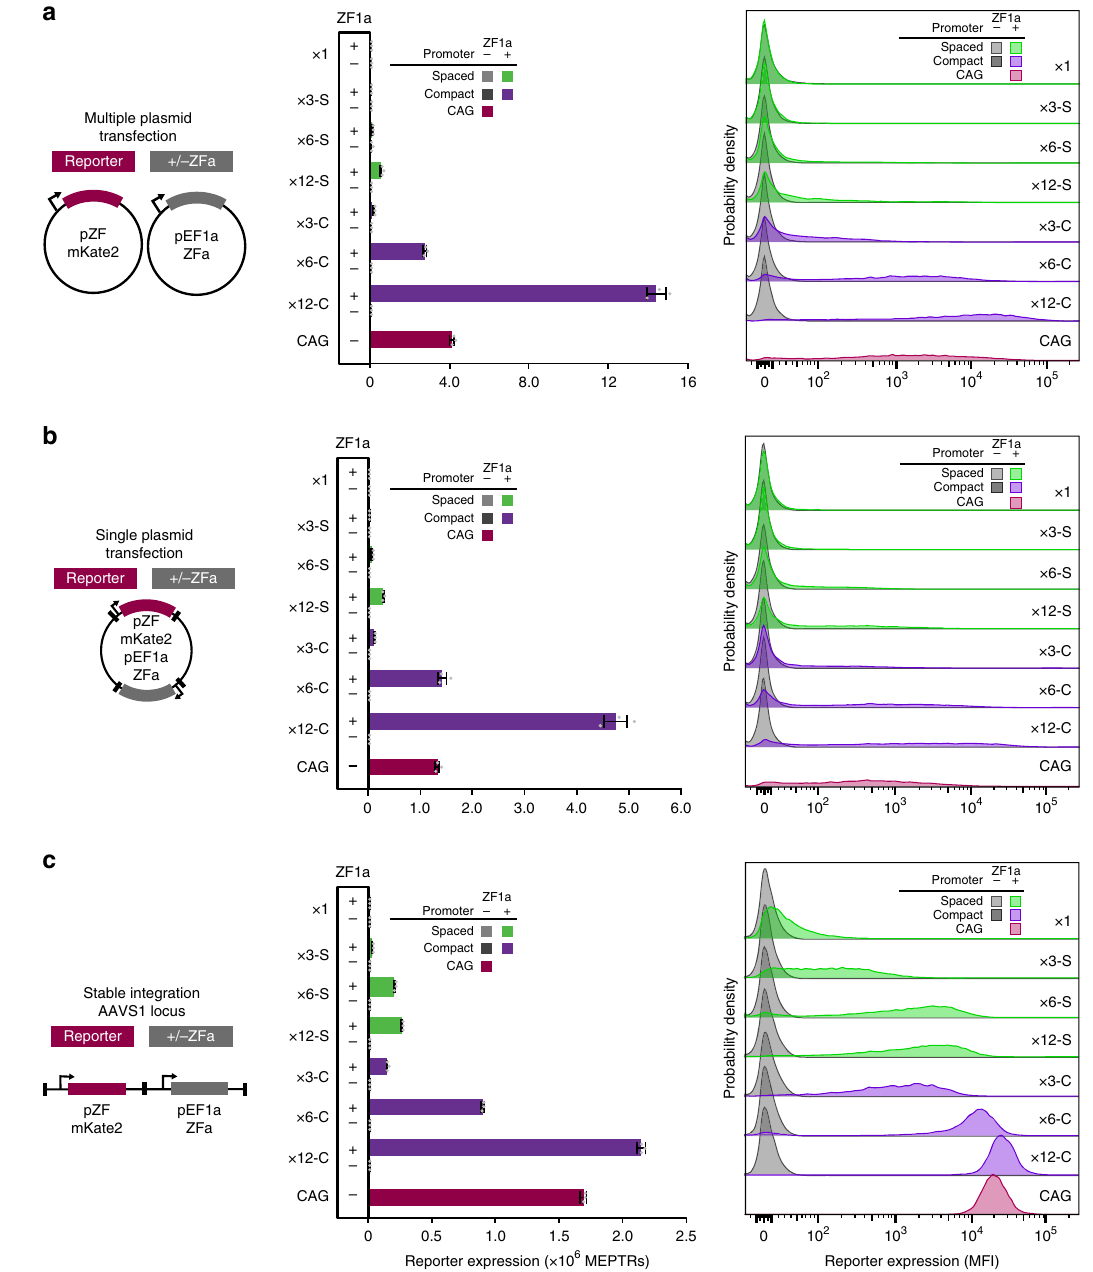
Fig. 6 Characterization of promoter design rules in the genome. The cartoons summarize the systems used to evaluate promoter performance characteristics across three contexts: ( a ) multiple plasmid transient transfection, ( b ) single plasmid transient transfection, and c single-copy stable integration at a genomic safe harbor locus. The promoters included here comprise 1, 3, 6, or 12 ZF1 binding sites positioned using spaced or compact architectures upstream of the YB_TATA minimal promoter driving an mKate2 reporter gene. Constitutive EBFP2 was used as a transfection control in the transient transfection context and as a marker for genomic locus activity in the stable context. Bar graphs and histograms show reporter expression for EBFP2-expressing cells. In all contexts, ZFa-induced gene expression increased with the number of binding sites on spaced and compact promoters (ANOVA p < 0.00001). To pro fi le the range of inducible expression conferred by each promoter, stable cell lines and transiently transfected cells were characterized using two distinct sets of fl ow cytometry settings (voltages), each of which was independently calibrated to yield comparable absolute fl uorescence units (bar graphs). Experiments were conducted in biologic triplicate, and data were analyzed as described in Methods. Error bars represent the S.E.M. Source data are provided in the Source Data fi VPR-based RaZFa, NES tagging of AD-FRB and NLS tagging of nuclear FKBP-ZF are suf fi cient to allow AD-FRB to drive FKBP-ZF decreased background while conferring little effect on transcription from the promoter, at higher nuclear levels the rapamycin-induced reporter expression, such that fold induction FKBP-ZF can act as an inhibitor. The decrease in background improved. To explain why the addition of NES to FKBP-ZF associated with the NES tag on AD-FRB was not due to increased background, we hypothesize that while low levels of decreased component expression (Supplementary Fig. 12f).